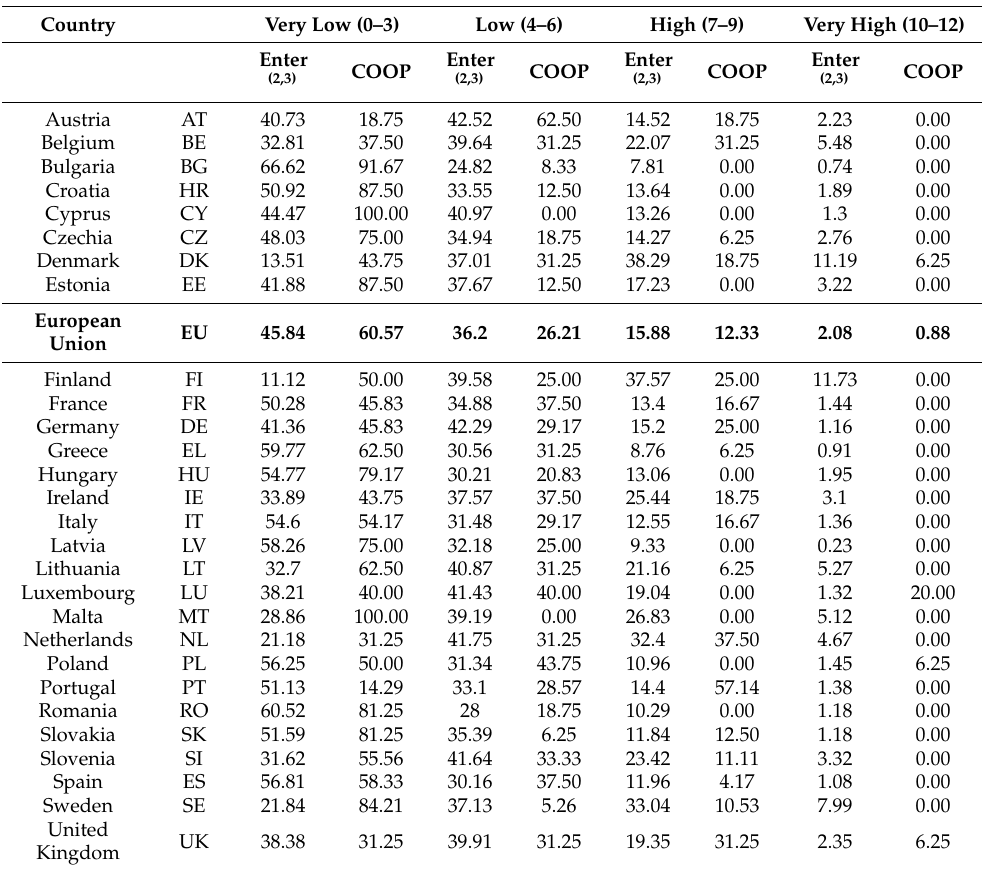
Table 6. Digital intensity score for enterprises (1) (2018) EU (28) and aggregate variable “Level of digitization” for agri-food cooperatives EU (28) clustered (2018–2019). Measure: percentage (%). Source: Own development based on data from the study and the EC Economy and Digital Society index available at: https://digital-agenda-data.eu/datasets/desi/visualizations (accessed on 20 August